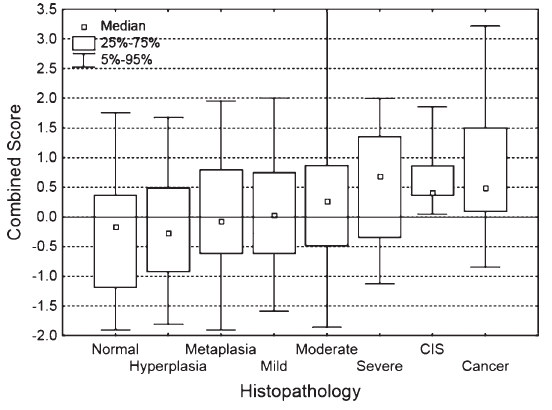
Fig.1. BoxplotsofCombinedScoreforsputumsamplescontaining more than 500 identifiable cells, grouped according to histopatho- logical grade. There is a general increase in the median Combined Score when progressing to more pathologically severe